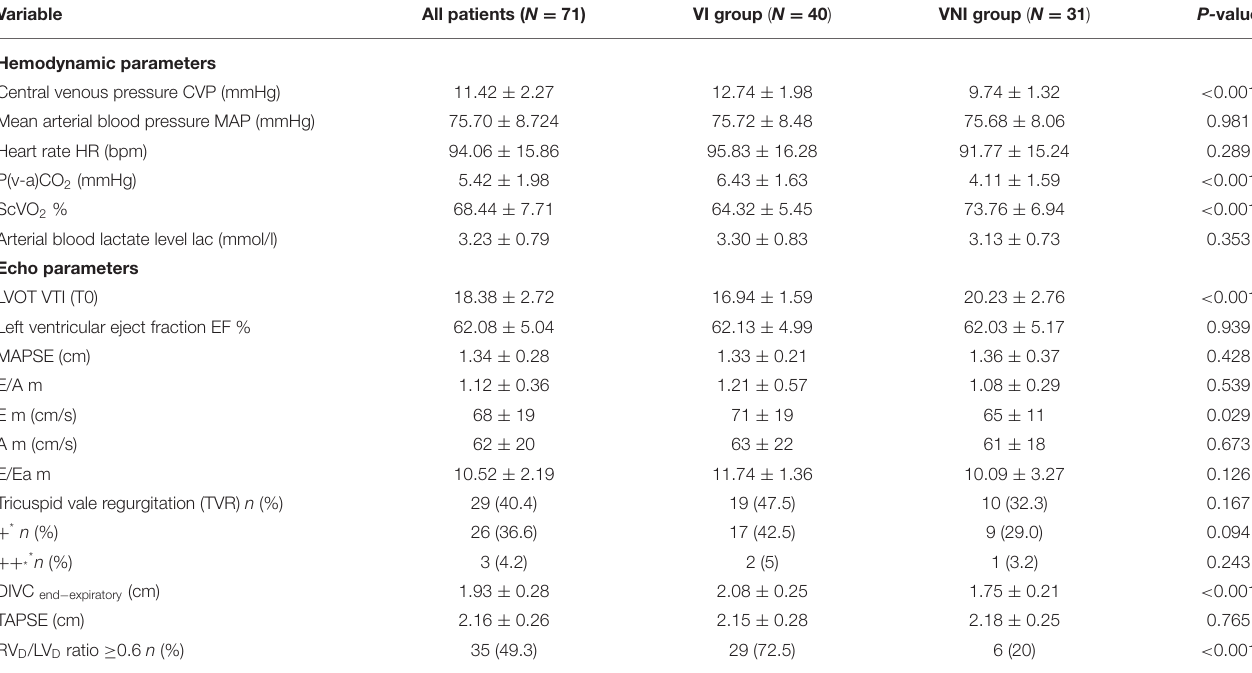
TABLE 2 | The hemodynamic and echo characteristics of all the included patients at T0. Variable